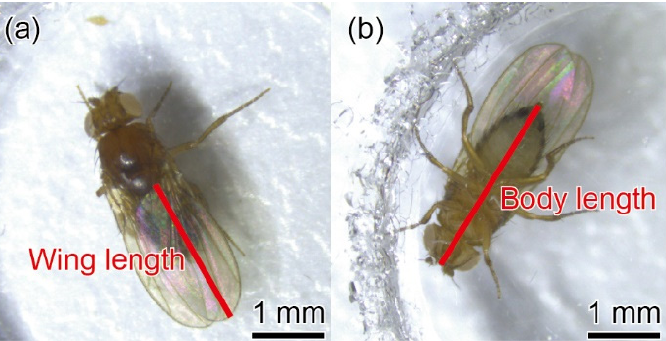
Figure 12. Photographs of ( a ) backside and ( b ) abdominal side of a fruit